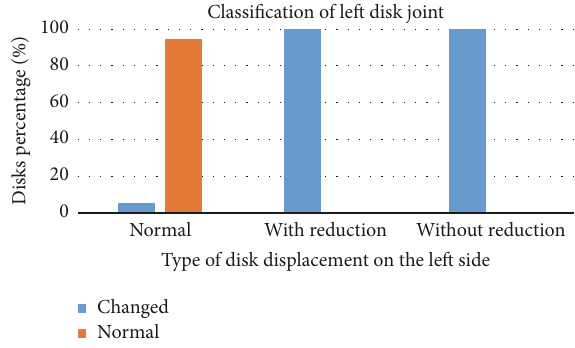
Figure 8: Association between disc classification and classification of disc displacement on the left